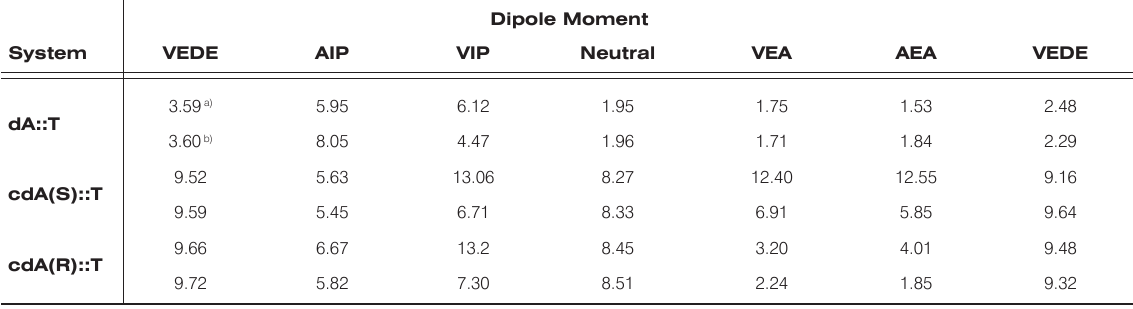
Table 3. Changes of cdA(S)::T , cdA(R)::T and dA::T dipole, in Debye, moment during electron attachment and detachment process. Dipole Moment System VEDE AIP VIP